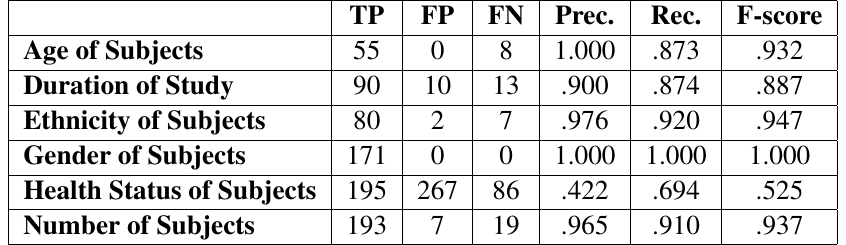
Table 3: Test set word match